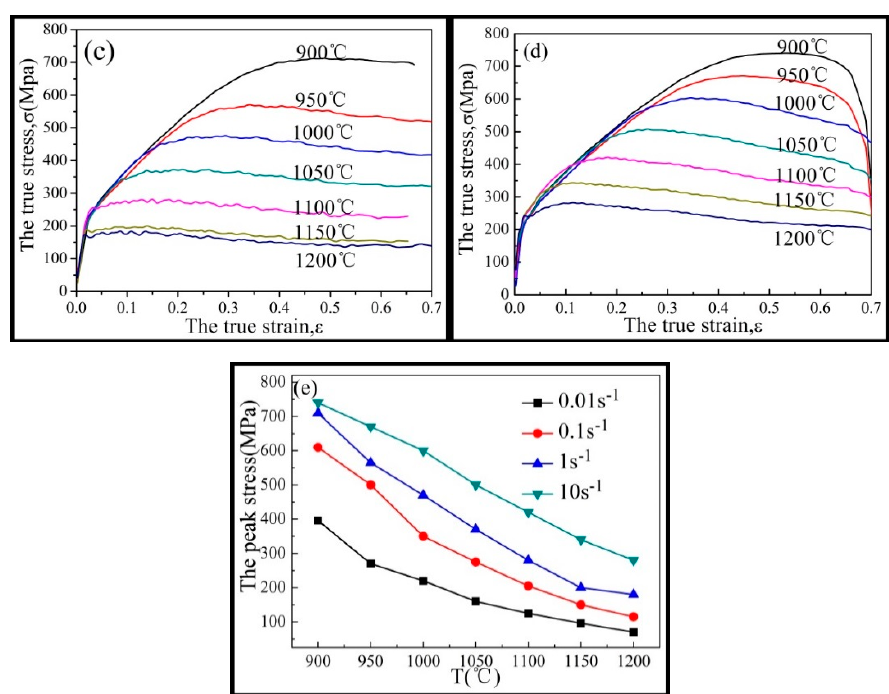
Figure 2. True stress–strain curves and peak stress curves of Inconel625 alloy at different strain rates and temperatures. ( a ) ε(cid:4662) = 0.01 s − 1 ; ( b ) ε(cid:4662) = 0.1 s − 1 ; ( c ) ε(cid:4662) = 1 s − 1 ; ( d ) ε(cid:4662) = 10 s − 1 ; ( e )The peak stress curves.